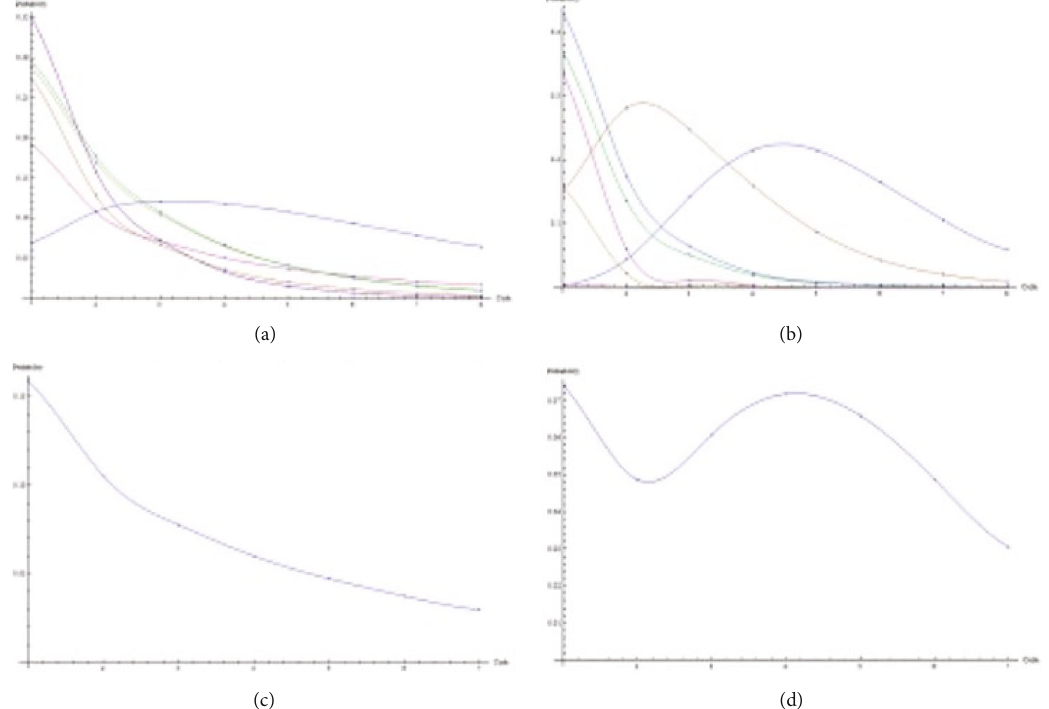
Figure 5: (a, b) Distribution patterns and mixtures of each of the component glyphs and (c, d) the mixtures obtained for (a, b),